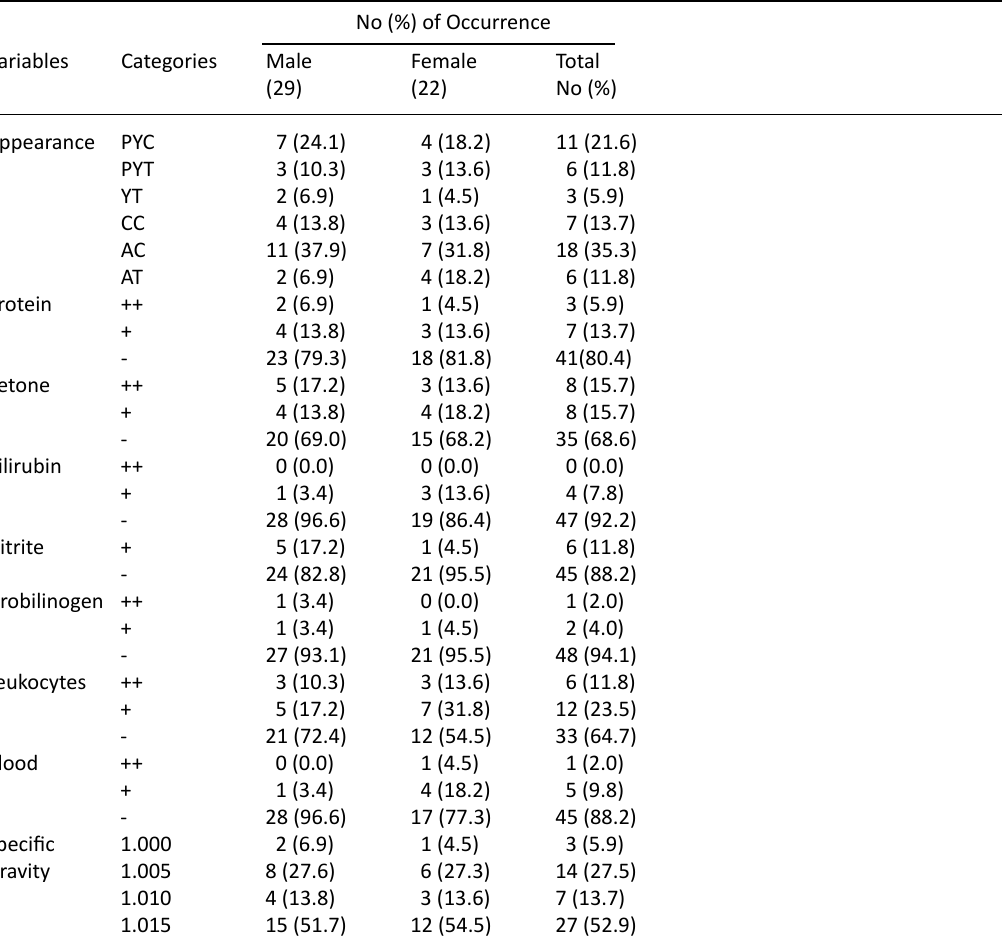
Table 2. Macroscopic and Chemical Analysis of Urine Samples of Diabetic Patients (n=51)